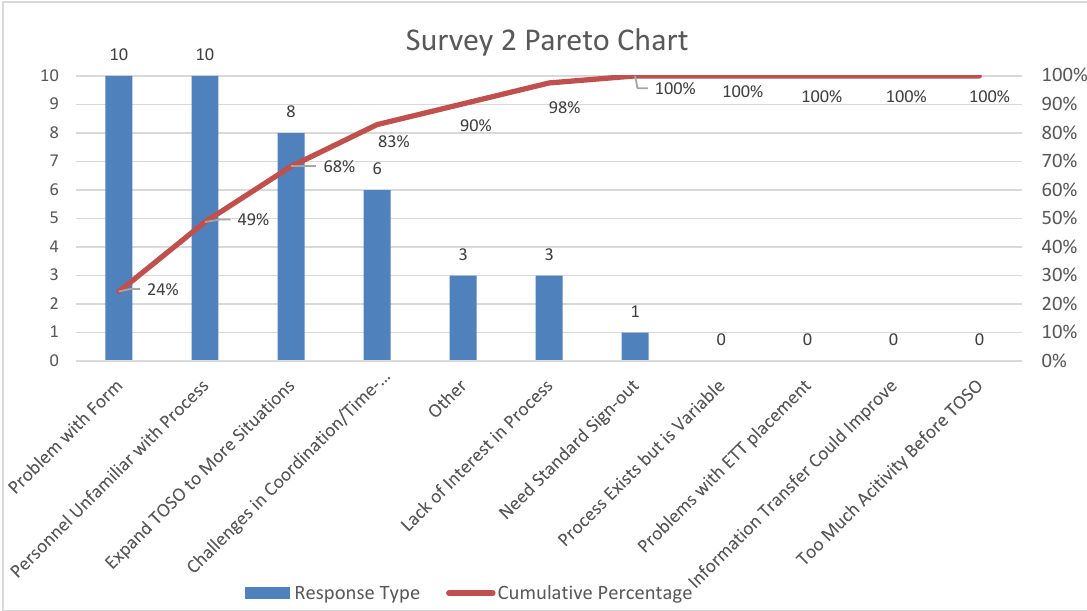
Figure 4. Pareto chart for comments from providers—Survey 2 (six-month post-implementation survey).